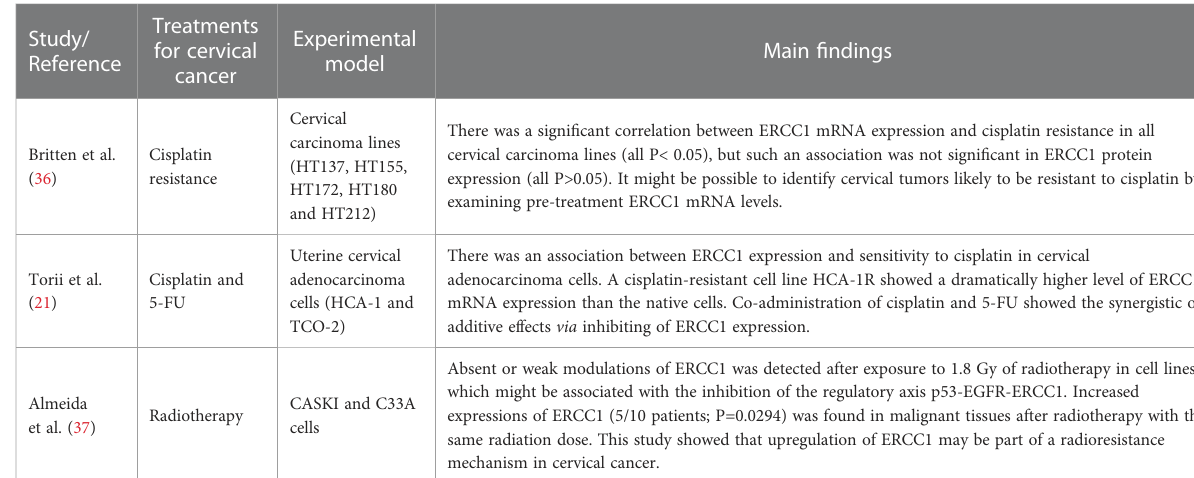
TABLE 3 Molecular mechanisms underlying the effects of ERCC1 in cervical